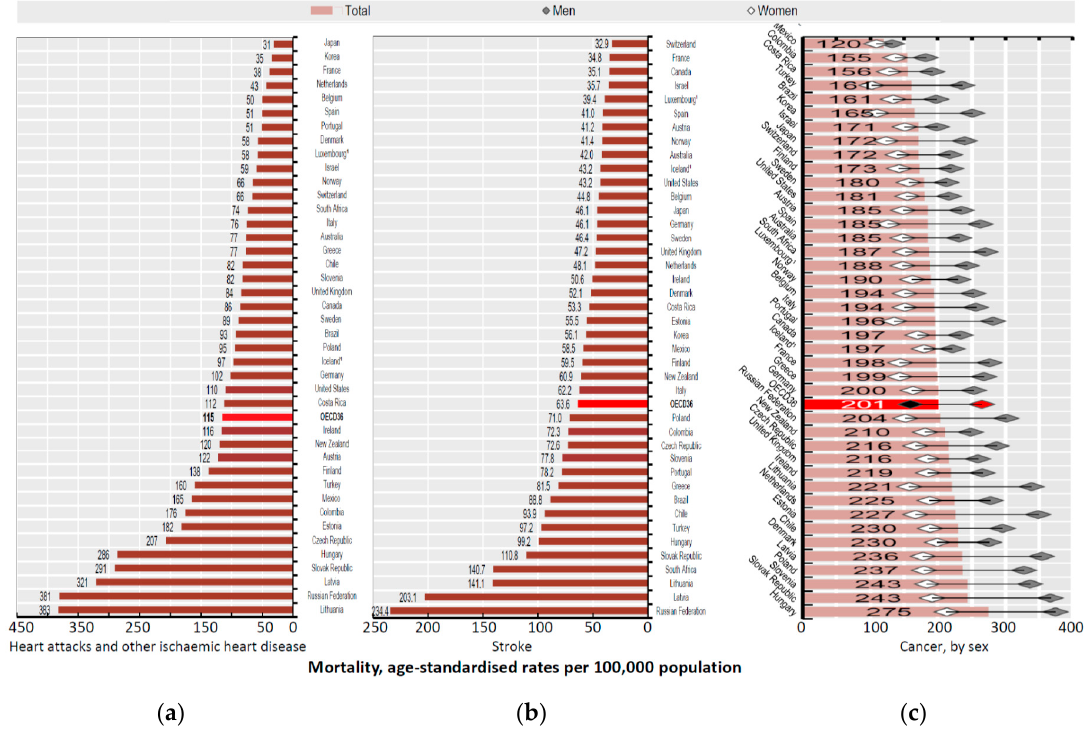
Figure 25. Comparison of morality due to ( a ) heart attacks and other ischemic heart diseases, ( b ) stroke, and ( c ) cancer by sex.